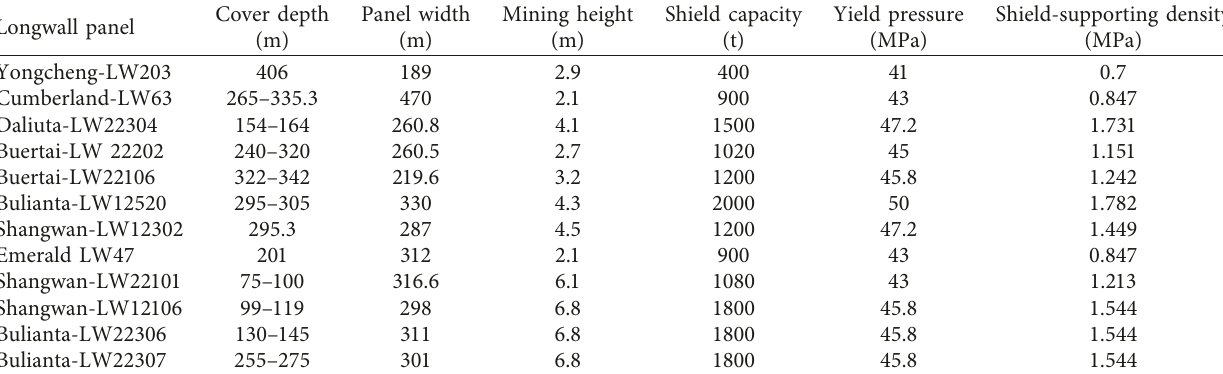
Table 1: Profile of study panels.